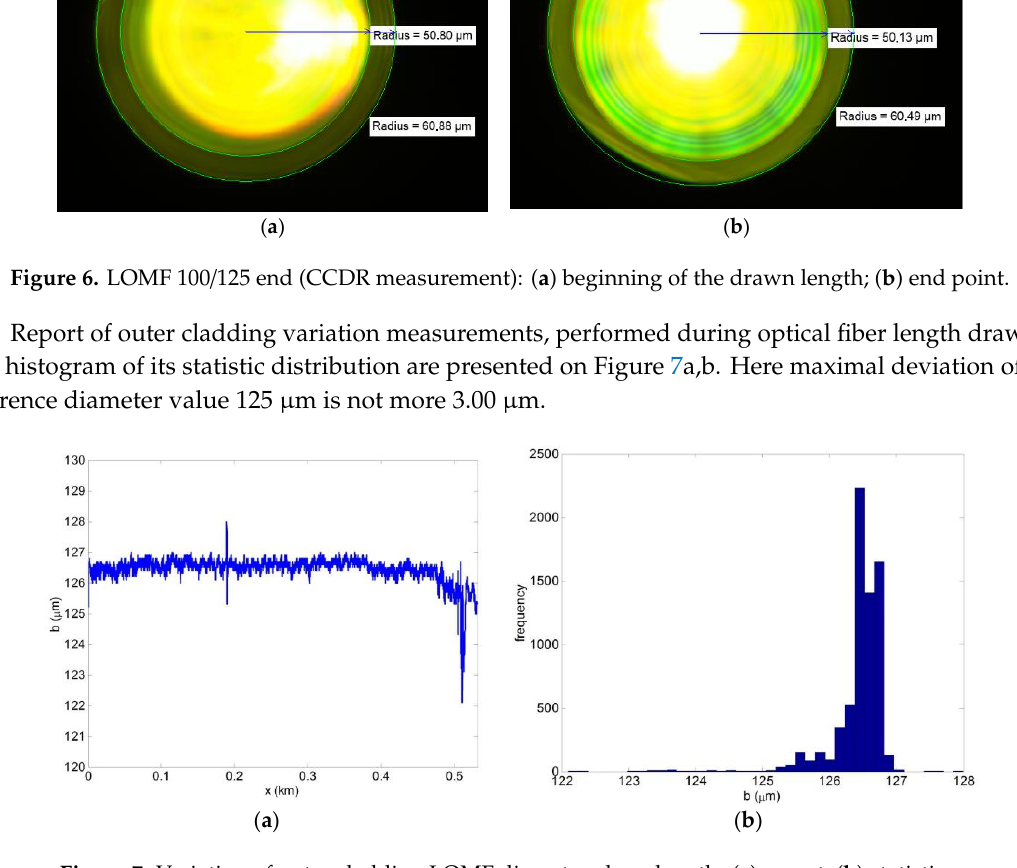
Figure 7. Variation of outer cladding LOMF diameter along length: ( a ) report; ( b ) statistics.